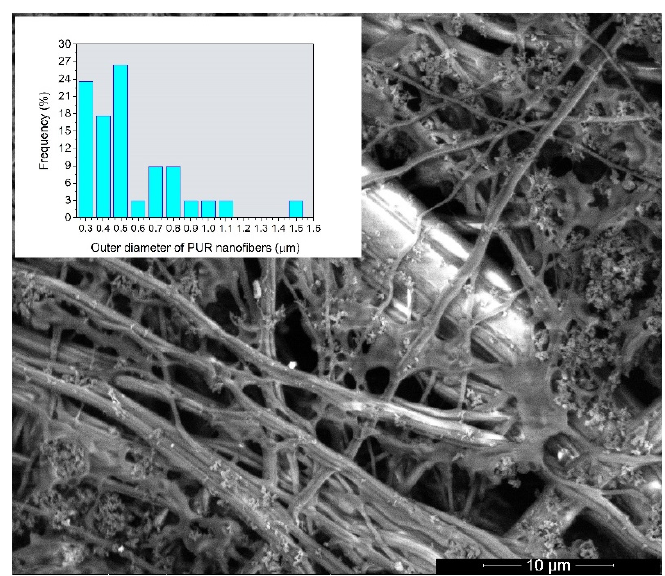
Figure 4. A HRSEM image of the modified S4 fabric with histogram of the outer diameter of PUR fibers inserted as an inset.